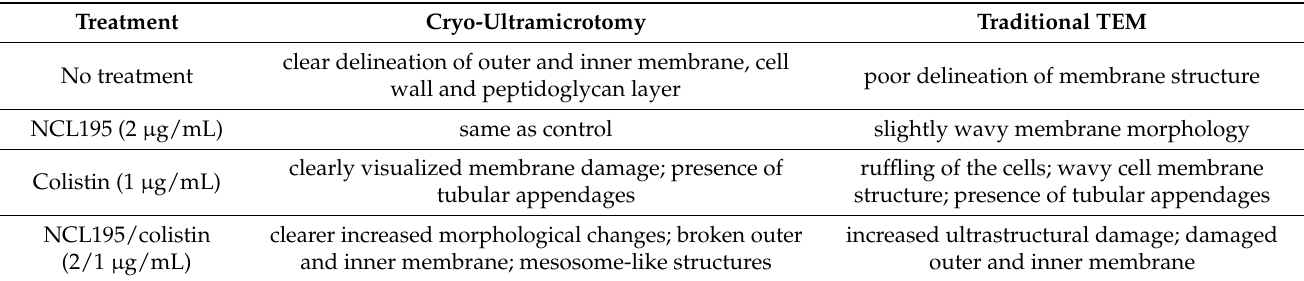
Table 3. Comparison of TEM using cryo-ultramicrotomy and traditional preparation methods to visualize the effect of drug treatments on Xen41 cell